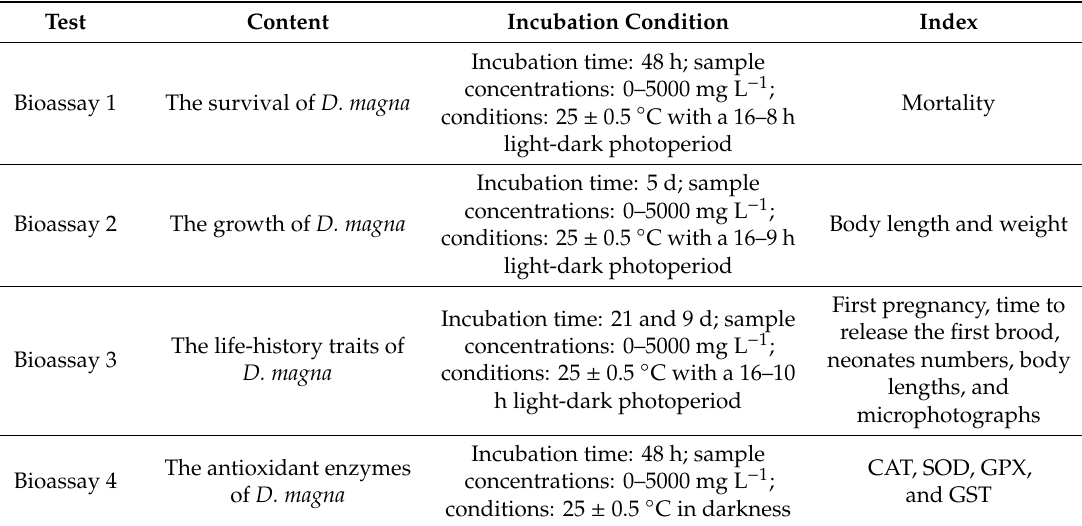
Table 1. The scheme of biological